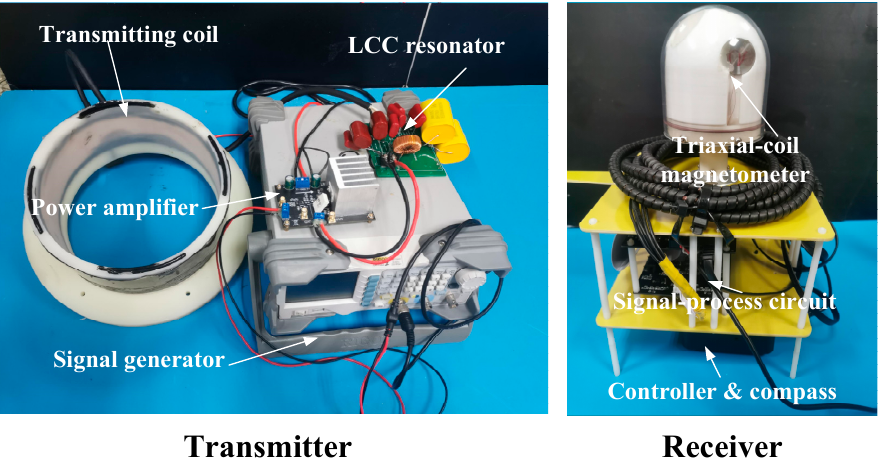
Figure 10. The prototype of the electromagnetic guidance system. Left and right are the electromagnetic transmitter and receiver, respectively. Table 5. Parameters of transmitting coil.